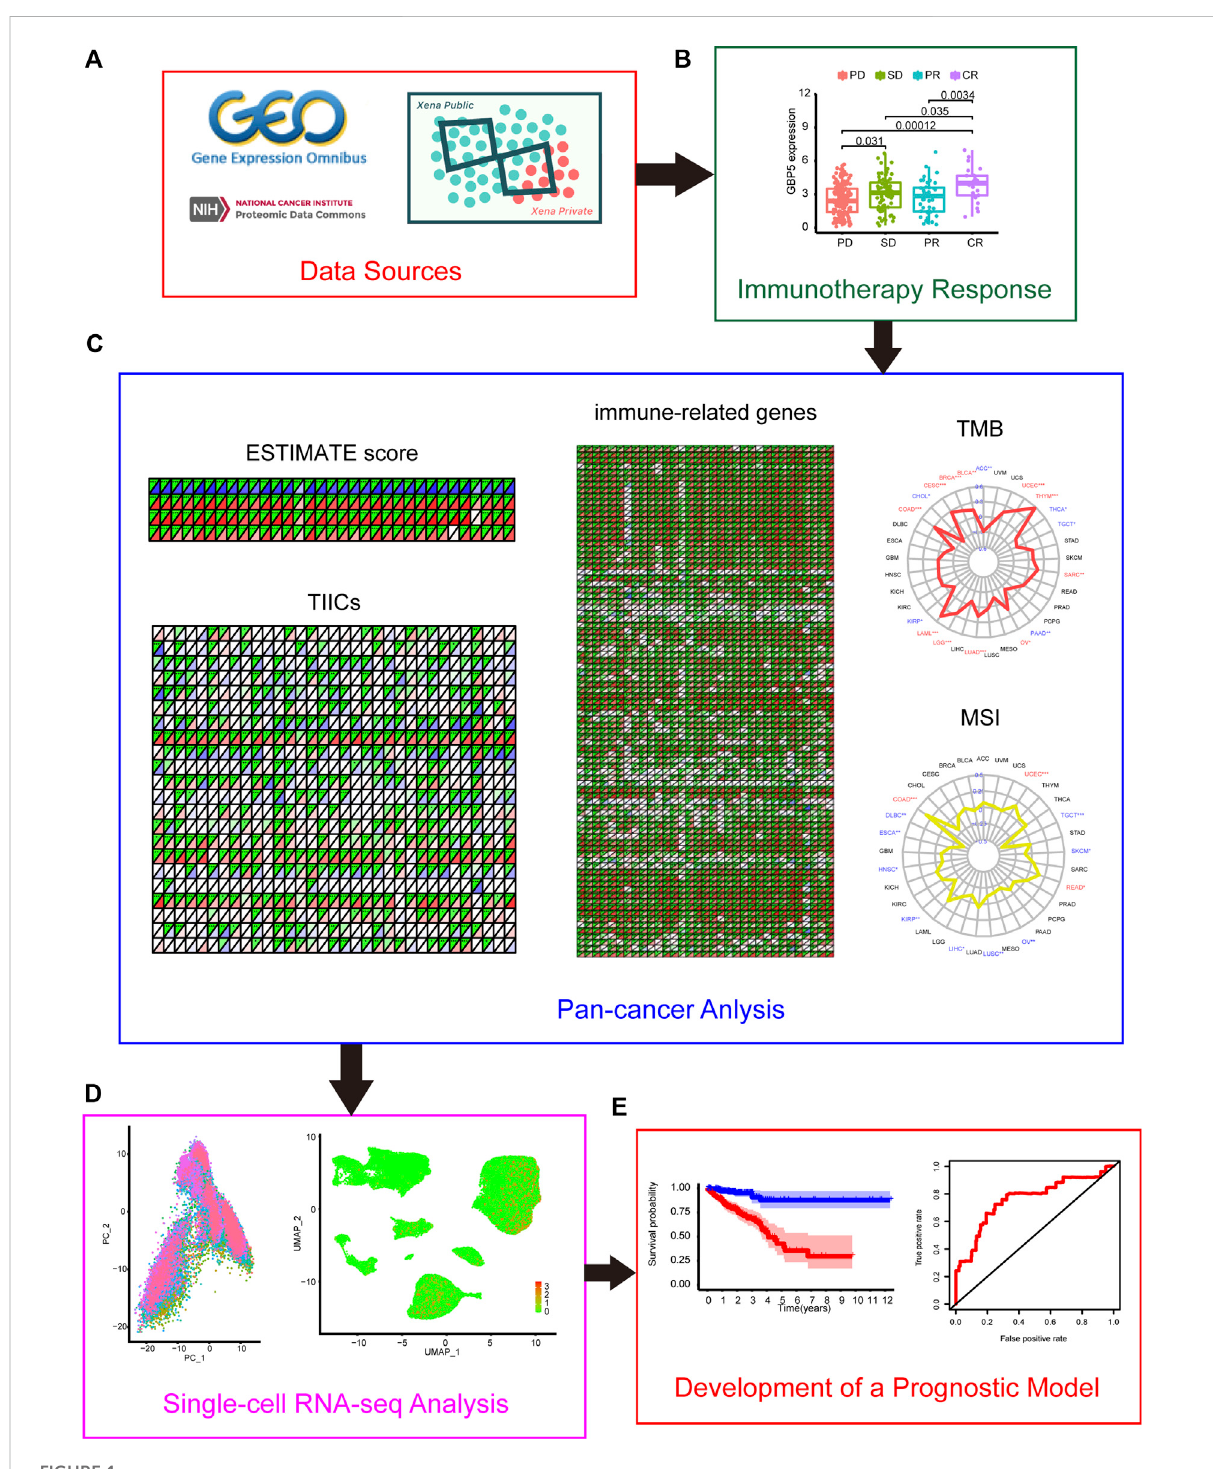
FIGURE 1 Flow chart of this study (A) Data sources of this work. (B) The correlation between GBPs (guanylate-binding proteins) and the effect of immunotherapy (C) Correlation between GBP5 and TME (tumor microenvironment) in pan-cancer (D) Single-cell analysis of GBP5 in CRC (colorectal cancer). (E) Construction of a GBP5-related prognostic model in